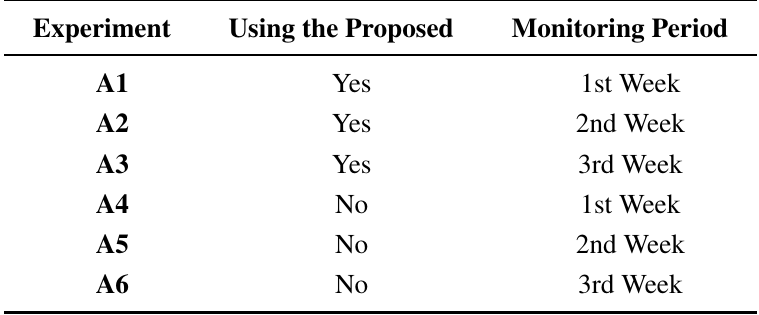
Table 3. Set of parameters selected for evaluation.